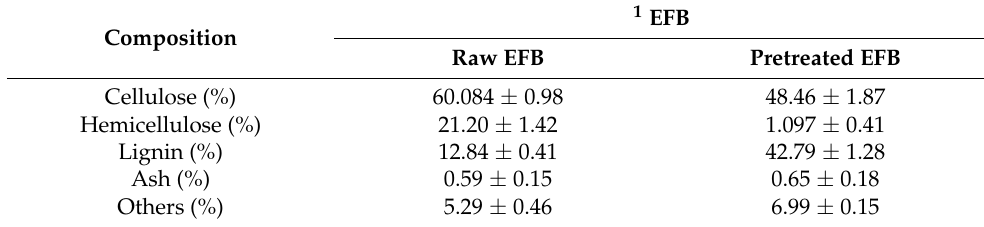
Table 2. Composition of raw and pretreated EFB.